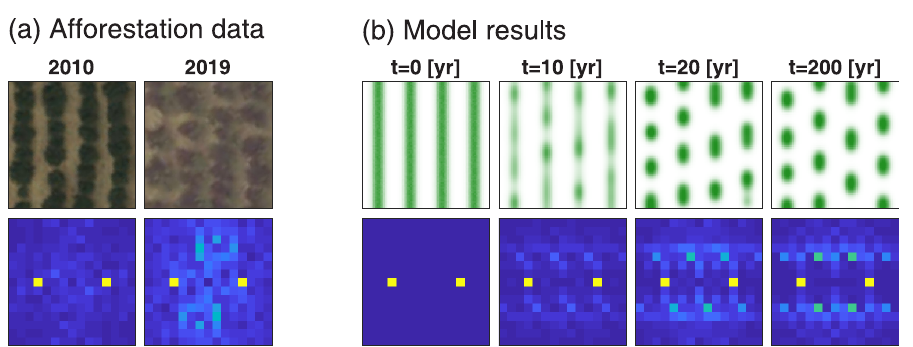
Fig 6. Emergence of oblique self-organized (SO) modes in afforestation projects. (a) A region of size 30x30 [m] containing four stripes of planted trees along bunds, taken from aerial images of the northern Negev region (Coordinates: 31.295N, 34.815E) in 2010 and 2019. (b) Model results of a comparable system, consisting of four initial vegetation stripes that has been subjected to a precipitation downshift from P = 205 to P = 180 [mm/yr] at t = 0, and simulated to t = 200[yr] (see full details in Materials and methods section and S1 Appendix). Note that similarly to Fig 3, but with different values of P , at high precipitation ( P = 205) both stripe and rhombic patterns are stable, but at low precipitation ( P = 180) stripe patterns are no longer stable. Top row shows spatial images, while bottom row shows spectral densities obtained from spectral (FFT) analysis, which demonstrates the periodicity of vegetation along different directions. The empirical spectral density in 2010 (a) shows the dominance of a stripe SO mode (yellow dots on x axis), representing the original planted pattern, while that in 2019 shows, in addition, the development of oblique modes (light-blue dots off the x axis), which represent vegetation mortality to form a spot-like pattern. The model simulations in (b) show a similar trend. During the transient dynamics towards a rhombic pattern the emerging pair of oblique modes are not symmetric (compare with Fig 4) both in the empirical data and the model simulations. However, simulations to longer times ( t = 200[yr]) indicate the eventual emergence of a symmetric pair of oblique